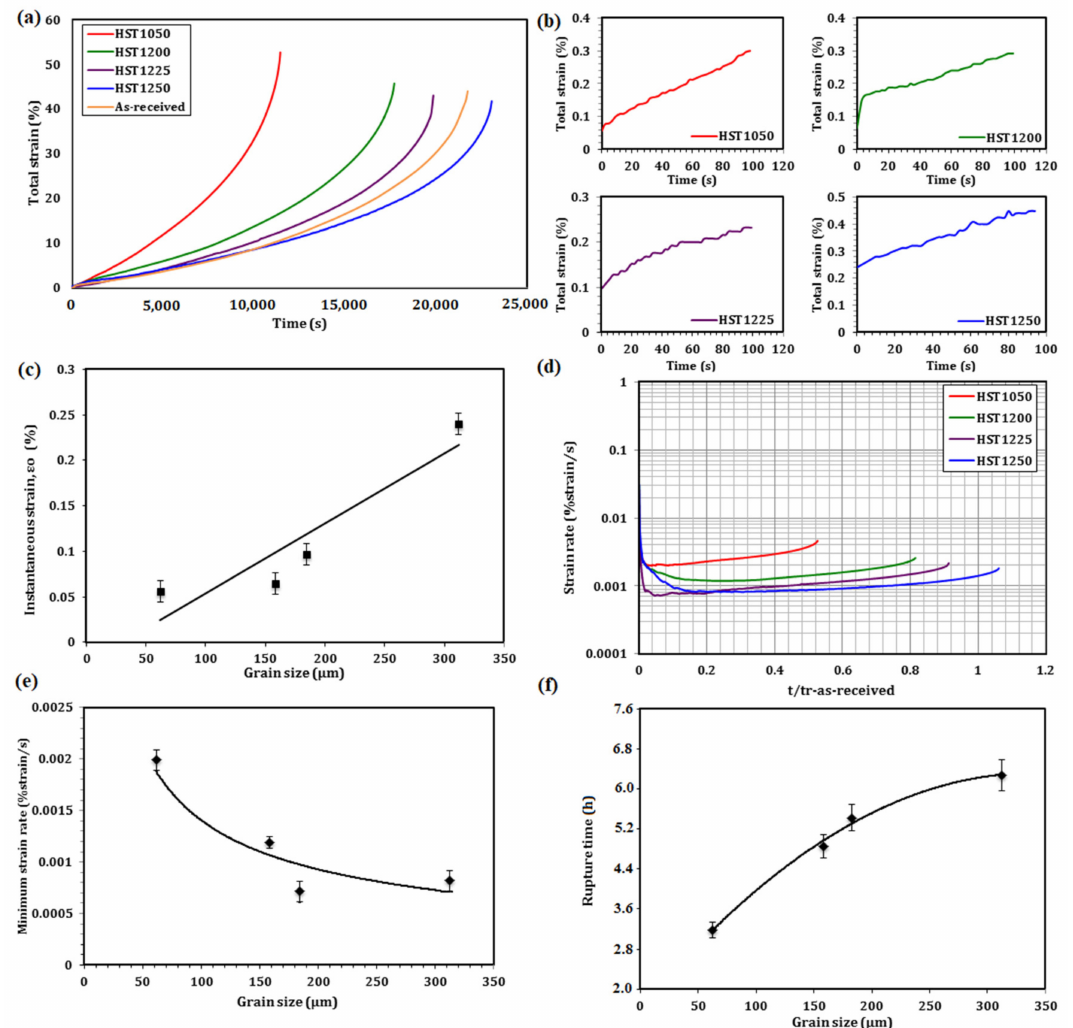
Figure 4. Creep curve of heat-treated Fe-40Ni-24Cr at temperature 900 ◦ C and initial stress of 100 MPa; ( a ) total strain versus time; ( b ) instantaneous creep strain; ( c ) instantaneous strain versus grain size; ( d ) strain rate versus time; ( e ) minimum creep rate versus grain size ( f ); creep rupture time versus grain size of the heat-treated